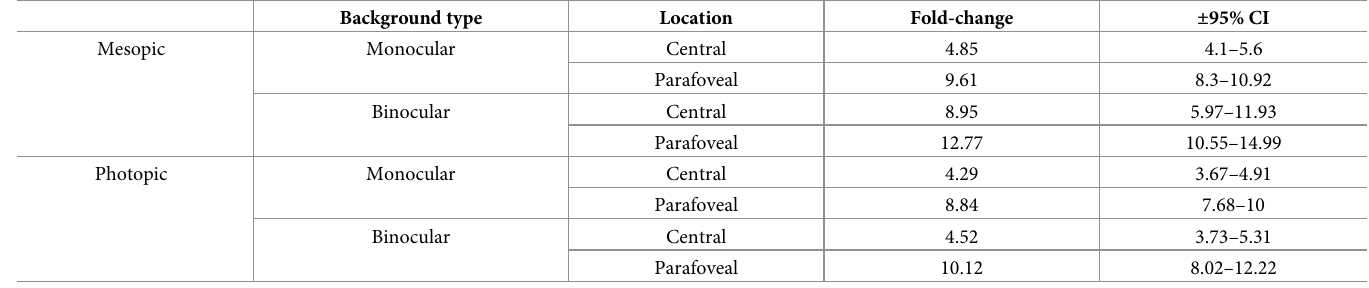
Table 2. Mean ( ± 95% CI) of fold-change in monocular and binocular FMTs from smallest (7’) to largest (60’) target size obtained for mesopic and photopic condi- tions for central and parafoveal target